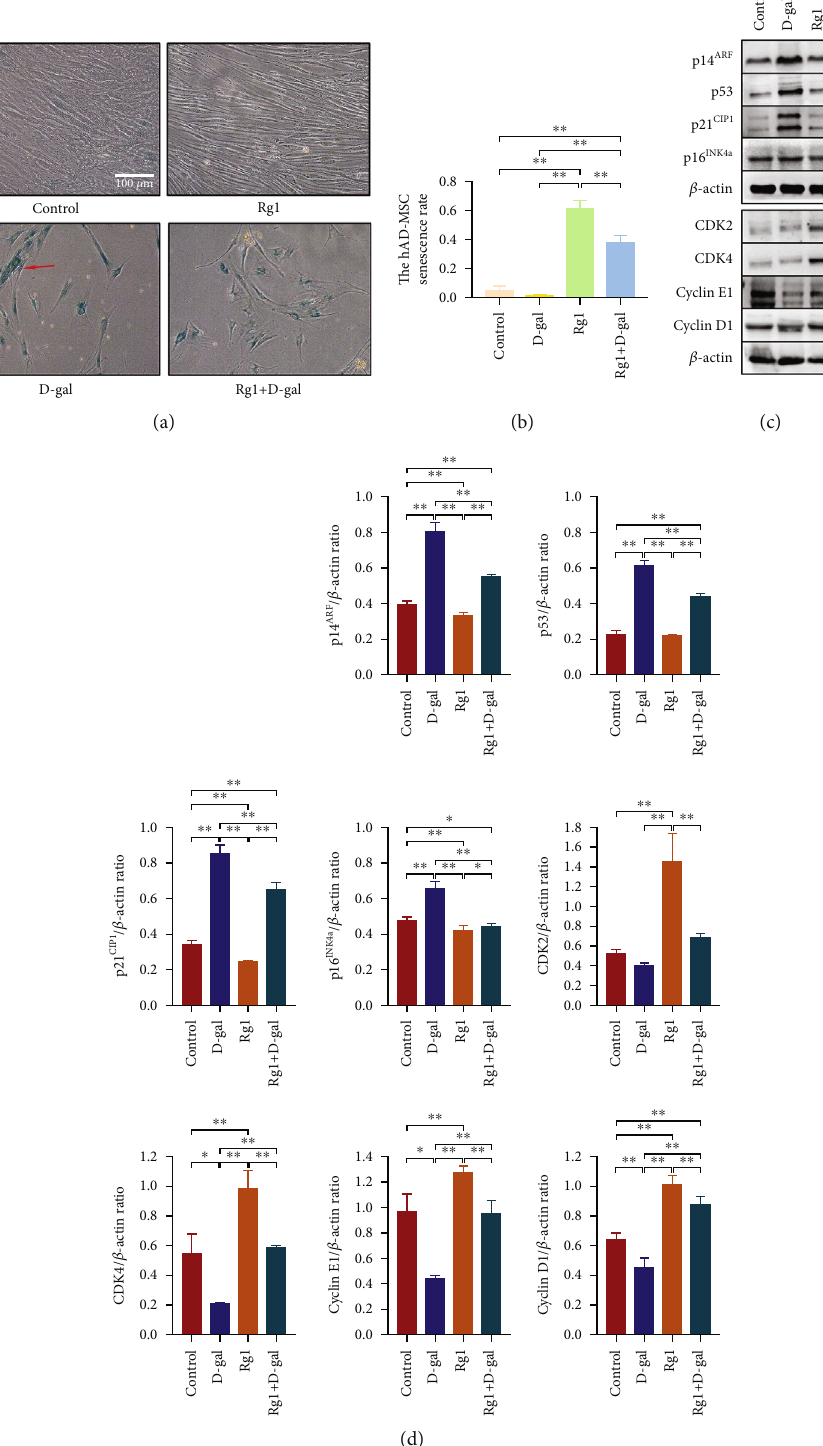
Figure 6: E ff ects of ginsenoside Rg1 on the senescence of hAD-MSCs. (a) Senescent cells were detected by SA- β -Gal staining in the control, D-gal, Rg1, and Rg1+D-gal groups ( × 100). (b) hAD-MSC senescence rates were compared in the control, D-gal, Rg1, and Rg1+D-gal groups. (c, d) The expressions of cyclin D1, cyclin E1, CDK2, CDK4, p14 ARF , p21 CIP1 , p53, and p16 INK4a in hAD-MSCs were analyzed (c) and compared (d) by western blot in the control, D-gal, Rg1, and Rg1+D-gal groups. Representative images are shown. The red arrow indicates senescent hAD-MSCs stained with blue. Scale bars=100 μ m. ∗ P < 0 : 05 and ∗∗ P < 0 : 01